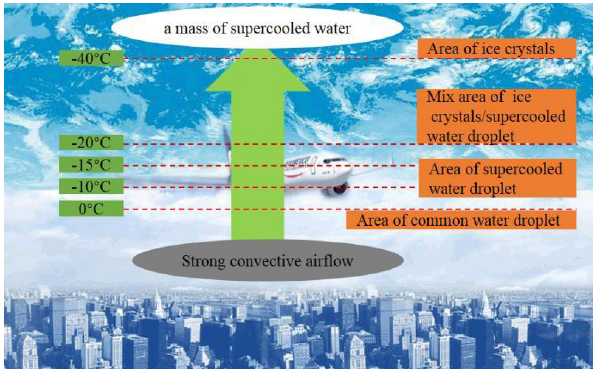
Figure 1. Distribution of ice crystals and supercooled water droplets in the clouds. Coatings 2018 , 8 , x FOR PEER REVIEW Figure 2. Three typical types of aircraft icing.